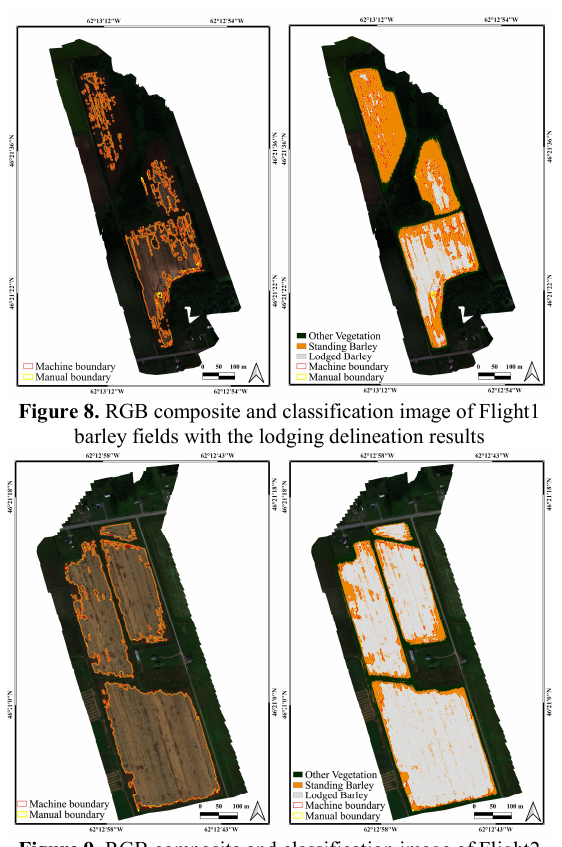
Figure 9. RGB composite and classification image of Flight2 barley fields with the lodging delineation